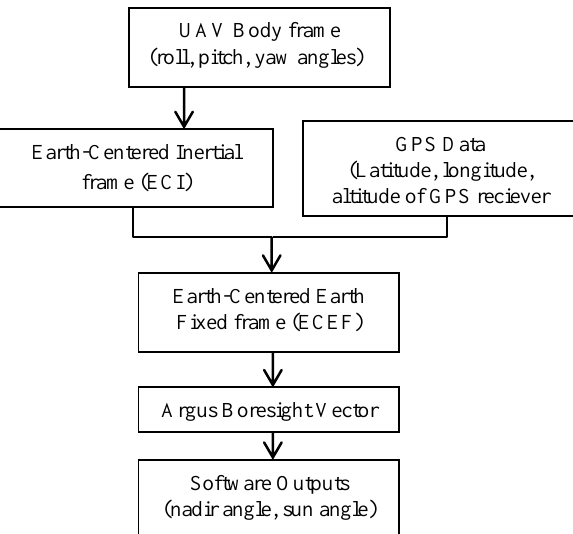
Figure 8. Flow-chart for UAV geolocation